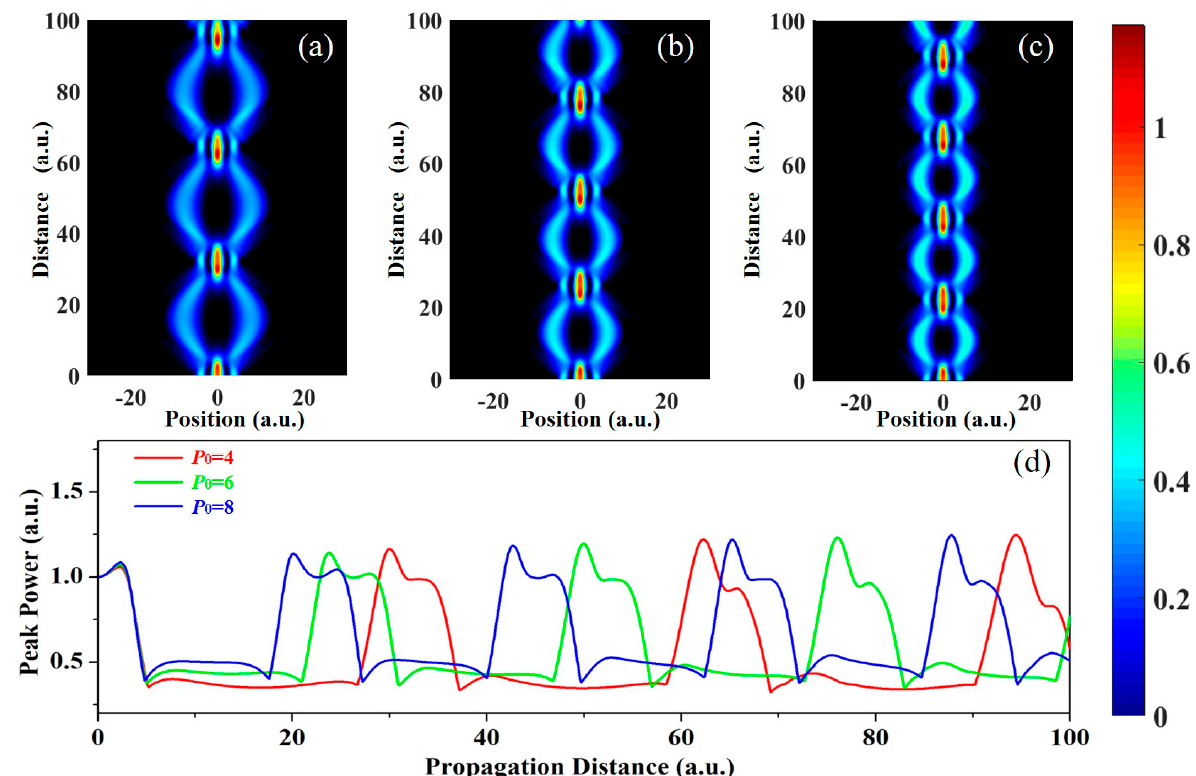
Figure 5. When x 0 = 1, ϕ 0 = 2 π /3, ω 0 = 0.03, the spatial evolution of Cos − Gaussian pulses with three different modulation intensities: ( a ) P 0 = 4, ( b ) P 0 = 6, and ( c ) P 0 = 8; ( d ) the peak power evolution of the breathing solitons: P 0 = 4 (red line), P 0 = 6 (green line), and P 0 = 8 (blue line). Lattice modulation frequency ω 0 is an important parameter affecting the breathing speed of the cosine potential optical lattice. In order to explore the effects of modulation in- tensity on the breathing soliton of the Cos − Gaussian beam, numerical simulation is carried out. For the optical lattice system with cosine nonlinear modulation, the Cos − Gaussian beam self-focuses for a short distance at the initial stage of propagation, and then the nonlinear self-focusing effect weakens and radiates outward. The energy of the sidelobes rebounds after meeting the potential well, forming a double-breathing soliton with an intertwined DNA structure (Figure 6a). The breathing solitons exhibit local characteristics in the space distribution direction and periodic respiration characteristics in the propaga- tion direction. With the increase in modulation frequency ω 0 , for the same longitudinal propagation distance ( z = 100), the pulse period gradually decreases, while the frequency gradually increases. The energy of the beam is gradually bound to the central waveguide and the breathing phenomenon gradually weakens (Figure 6b,c). It is noteworthy that the modulation frequency ω 0 can slightly change the maximum intensity of the breathing soliton (Figure 6d). The energy of breathing solitons is conserved throughout the transport process. Through the above analysis, it is known that the maximum breath of width and frequency of the spatial solitons can be controlled by changing the lattice modulation frequency. It is concluded that the numerical simulation results are consistent with the theoretical analysis from Equation